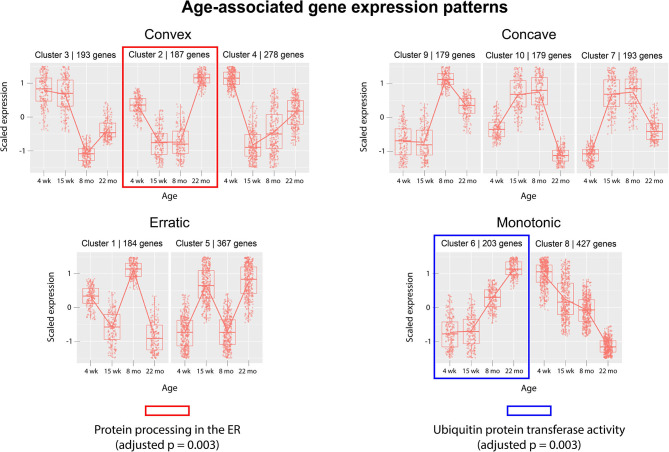
Clusters of differentially-expressed genes in the aging murine heart transcriptome. Clustering was performed using DEGreport's implementation of divisive hierarchical clustering (Pantano, 2019). Genes with adjusted p-value < 0.05 (calculated by the likelihood ratio test for age) were clustered according to log2 normalized read counts. Each cluster's number is provided in the title of each scaled expression graph, along with the number of genes in that cluster. Genes are plotted on the y-axis according to a scaled expression value (z-score), calculated as each gene's distance from the mean log transcript count of all genes in that cluster divided by the standard deviation of log transcript counts in that cluster. A box plot is constructed for each time point, with median expression level denoted by a horizontal line. Lines also connect the mean expression levels of consecutive time points, to display an expression path typical of that cluster. Genes that did not match the expression profiles of any of the 10 clusters were omitted. Pathway and ontology analysis was implemented on all 10 clusters, and gene sets with statistically-significant enrichment were identified in cluster 2 (red) and cluster 6 (blue). Cluster 2's genes exhibit high expression levels in both juvenile and elderly mice but are down-regulated in adolescent and adult mice, while the genes in cluster 6 exhibit a monotonic increase in expression as mice age past 15 weeks.